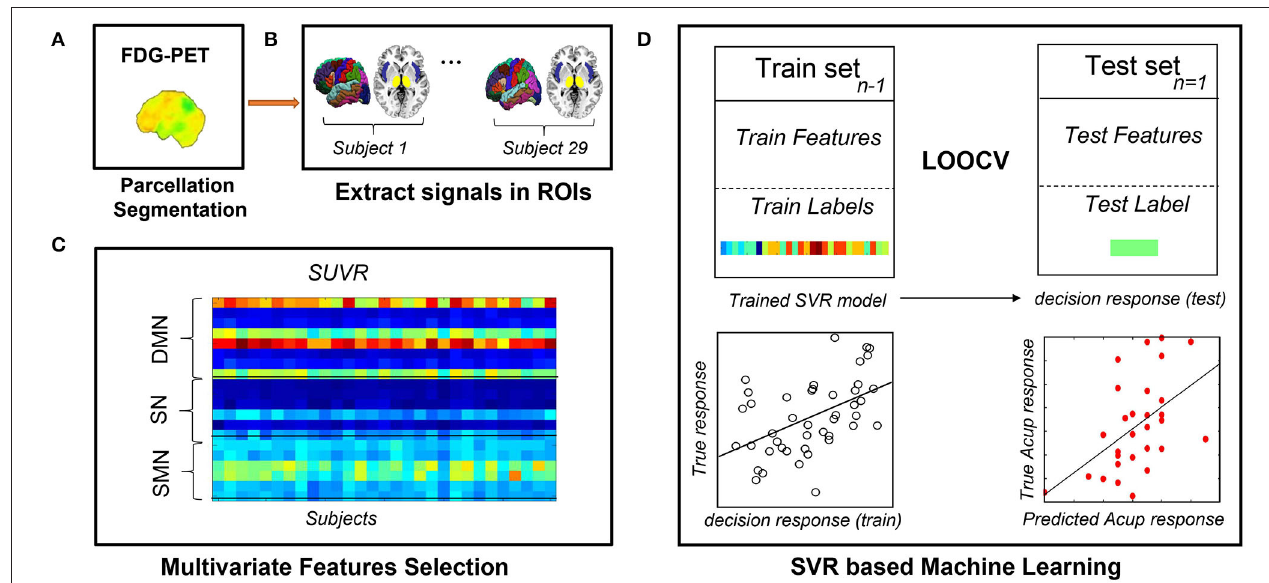
FIGURE 3 | Flowchart of the MVPA procedure. (A) Obtaining quantitative information from preprocessed PDG-PET scans. (B) Extracting metabolism data across all voxels in all ROIs. (C) Constructing feature matrixes of the SUVR. (D) Building the SVR model with LOOCV to predict each participant’s response to acupuncture. FDG-PET, fluorodeoxyglucose positron emission tomography; LOOCV, leave-one-out cross-validation; ROIs, regions of interest; sMRI, structural magnetic resonance imaging; SUVR, standardized uptake value ratio; SVR, support vector